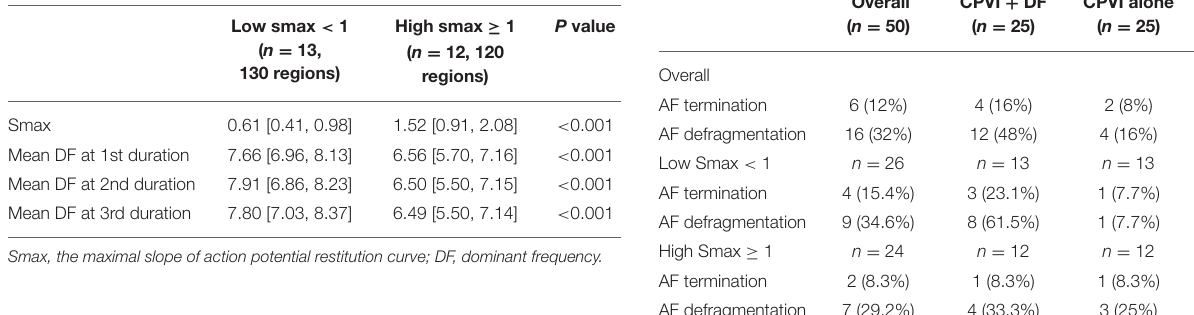
TABLE 1 | Comparing the dominant frequency of three consecutive periods between the low and high Smax conditions in computational simulation.